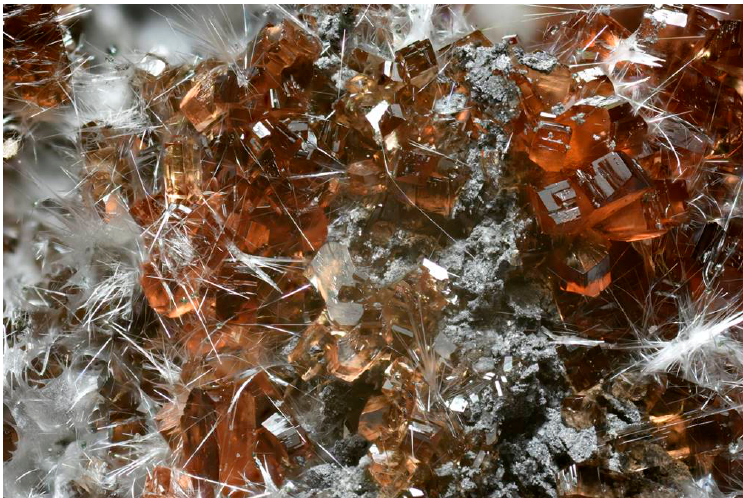
Figure 20. Römerite, prismatic crystals up to 1.5 mm with acicular crystals of halotrichite from the Fornovolasco mine.